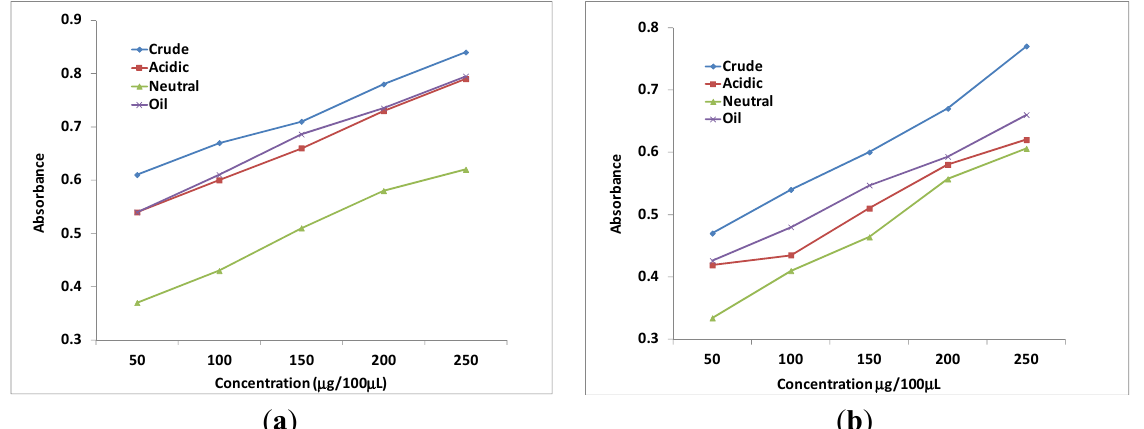
Results are expressed as mean ± standard deviation ( n = 3). Values with in a column and with in a row were all significantly different ( p < 0.05) except between column b and d. Figure 1. Reducing power of crude extract, acidic and neutral fraction and oil from ( a ) Ajwain seeds, ( b ) mustard, ( c ) fenugreek and ( d ) poppy seeds. Results are expressed as mean ± standard deviation ( n = 3), all significantly different ( p < 0.05) except difference between acidic fraction and